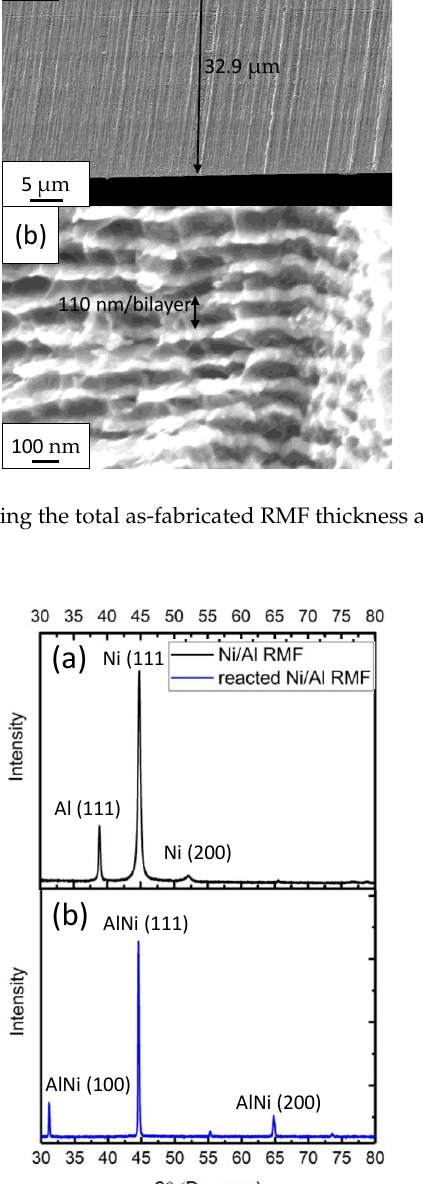
Figure 3. XRD pattern of the Ni/Al RMF ( a ) as-fabricated and ( b ) post ignition.